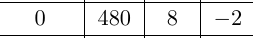
Table 11 . The refined GV numbers n g L ,g R the integer